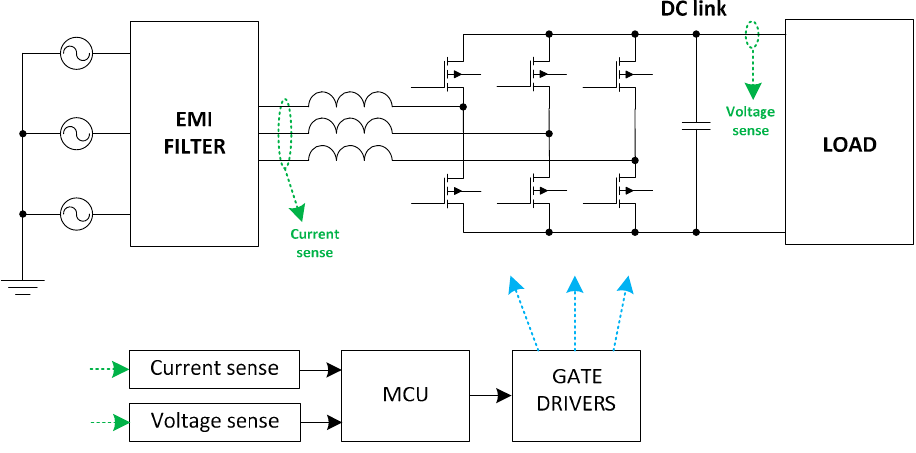
Figure 2. Block diagram of 3-phase inverter circuit.